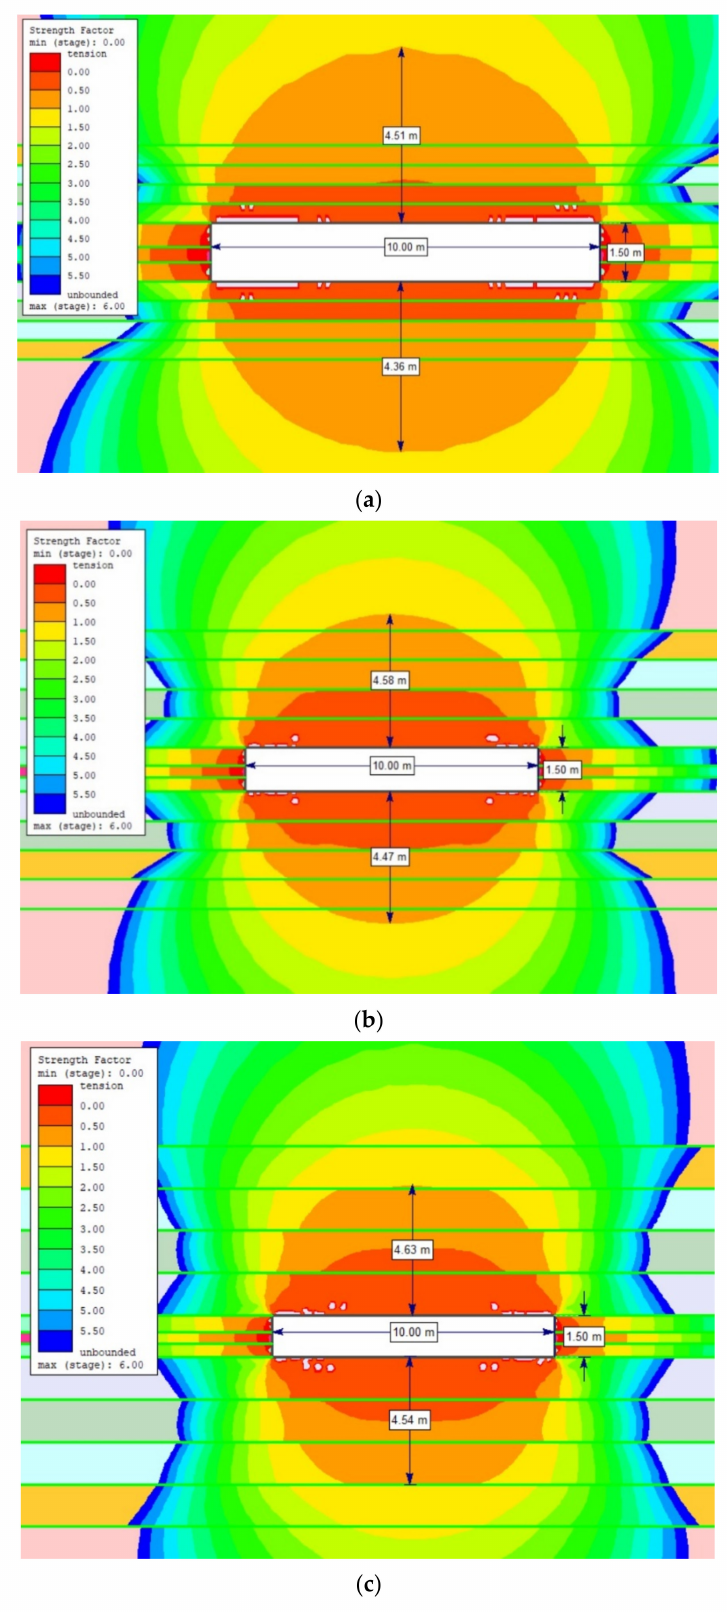
Figure 12. The extent of the rock destruction zone around the gasification channel with a width of 10 m and the impact of temperature of 1200 ◦ C for the dry rock mass, up to the height of: ( a ) 0.5 m; ( b ) 1.0 m; ( c ) 1.5